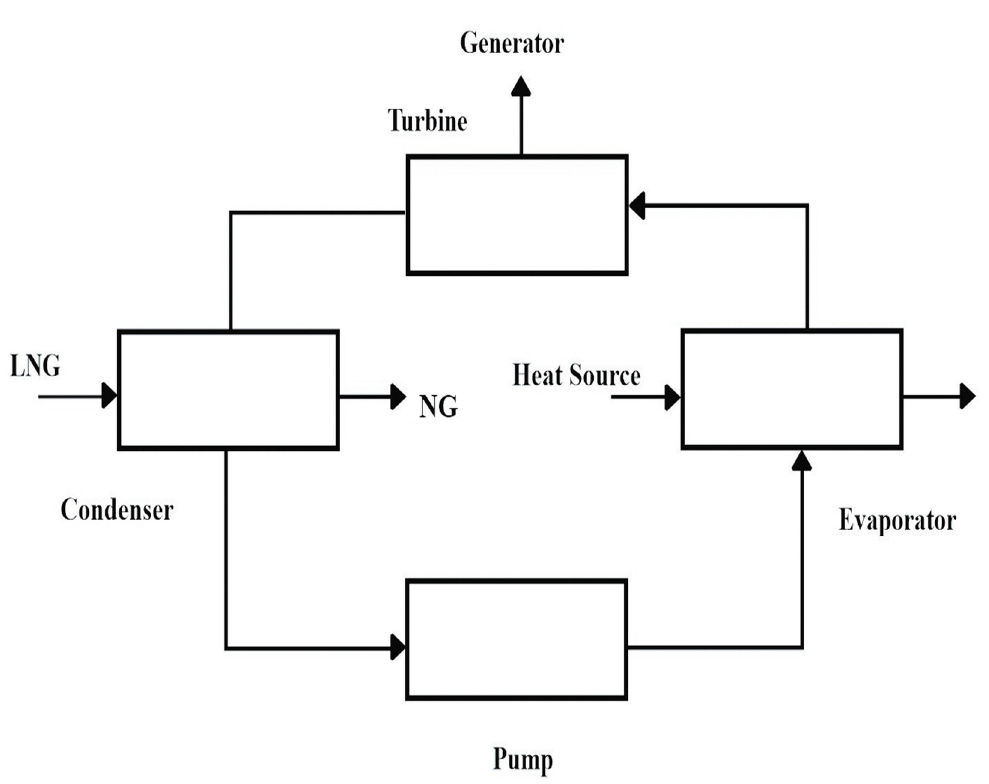
Figure 2. Schematic of LNG regasification integrated through the ORC energy system. Table 1. Detail of the fi xed parameters used for simulation of LNG regasi fi cation process-ORC- ANSU energy system.